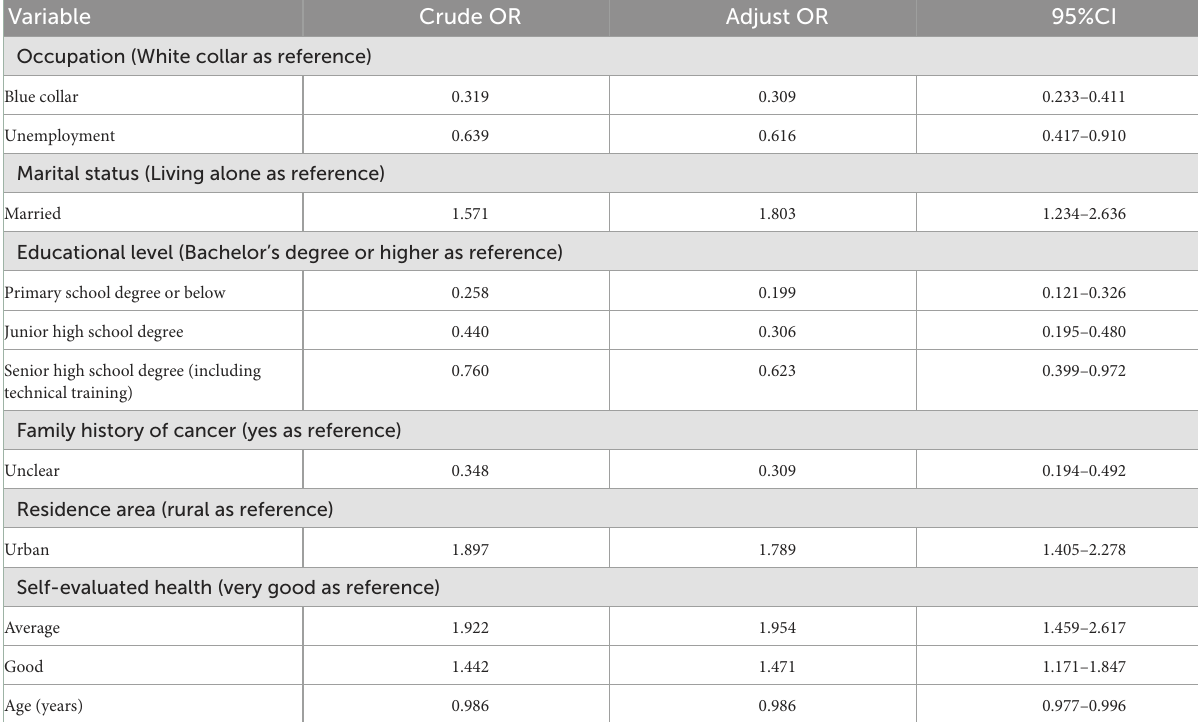
TABLE 3 Odds ratios and 95% confidence intervals for having a high cancer prevention and control core knowledge by sociodemographic and other factors in Fujian Province, China.